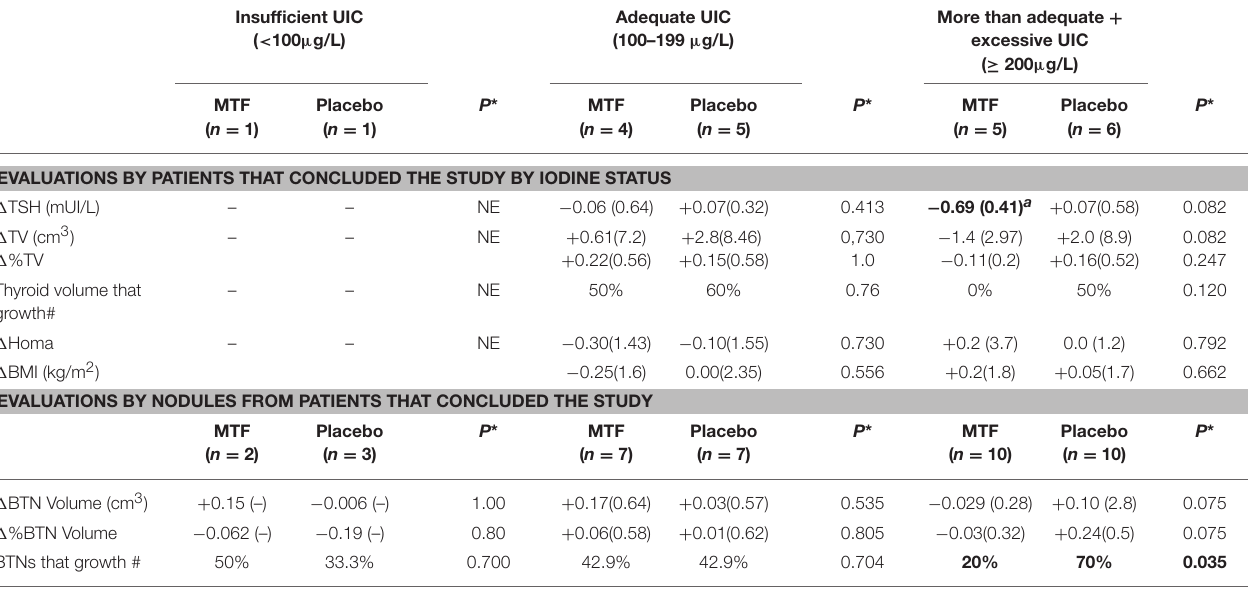
TABLE 3 | Stratified analysis by iodine status: comparisons between outcome variables in MTF and Placebo groups during the